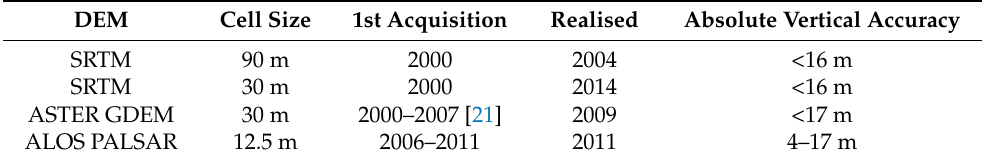
Table 1. Summary of the DEM features.